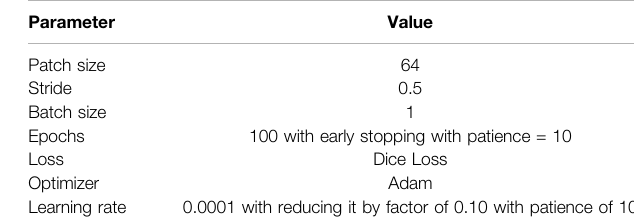
TABLE 2 | Parameters used for training 3D